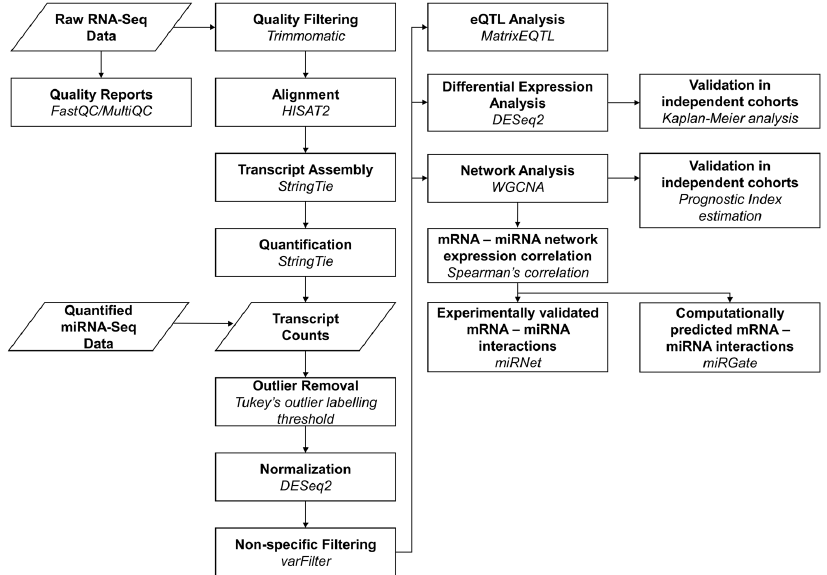
Figure 1. Flowchart of study analysis pipeline. First, reports of read-sequence quality were gener- ated using FastQC [20] and MultiQC [21], followed by trimming of low-quality mRNA-seq reads with Trimmomatic [22]. Filtered reads were aligned to the hg19 human reference genome [23] using HISAT2 (hierarchical indexing for spliced alignment of transcripts) [24] and quantified by StringTie [25]. miRNA-seq data were obtained as quantified reads from the Cancer Genome Atlas [26]. Next, transcript expression was normalized using the DESeq2 R package [27], and highly variable transcripts were selected with the varFilter function of the genefilter R package [28]. Moreover, transcript expression was used to test for differential expression using DESeq2 and to construct coexpression networks using the weighted correlation network analysis (WGCNA) R package [29]. Interactions between miRNAs and mRNAs from significant WGCNA networks were detected using Sperman’s correlation, and validated using miRNet [30] and miRGate [31]. Validation of differential expression analysis results was performed using Kaplan–Meier analysis on two independent HGSOC cohorts. Validation of network analysis results was performed using the Prognostic Index estima- tion method from the SurvExpress tool [32] on the same validation cohorts. Transcript expression data were integrated with genomics data from the same patients to determine eQTLs (expression quantitative trait loci) using the MatrixEQTL R package [33].